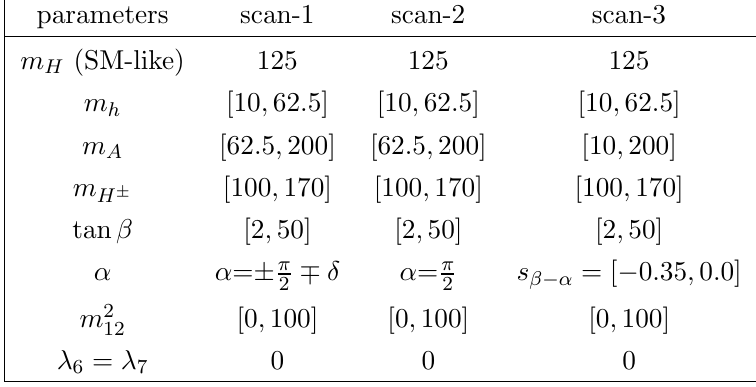
Table 1. 2HDM parameters scans: all masses are in